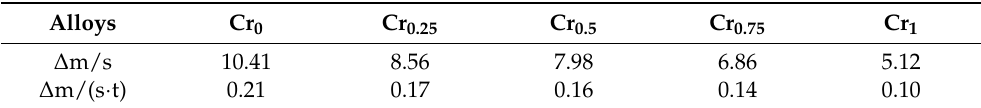
Table 3. Weight gain (mg/cm 2 ) and weight-gain rate (mg/cm 2 ·h) of WVTaTiCr x RHEA coating after oxidation at 800 °C for 50 h.